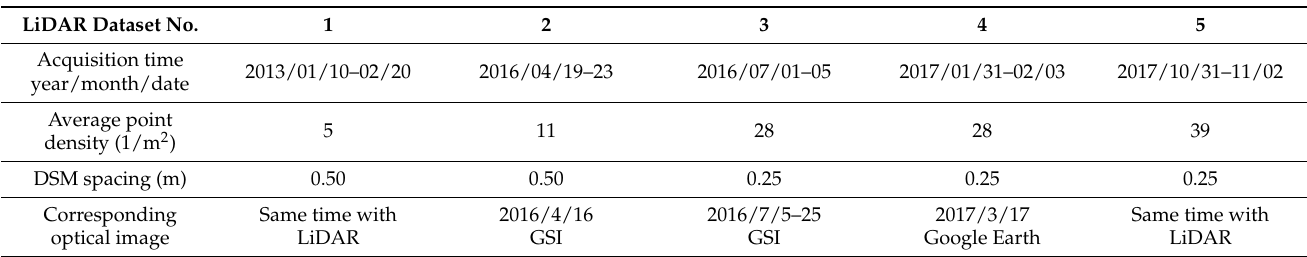
Table 1. Acquisition time, average point density, and DSM spacing, and corresponding optical images of the LiDAR datasets used in this